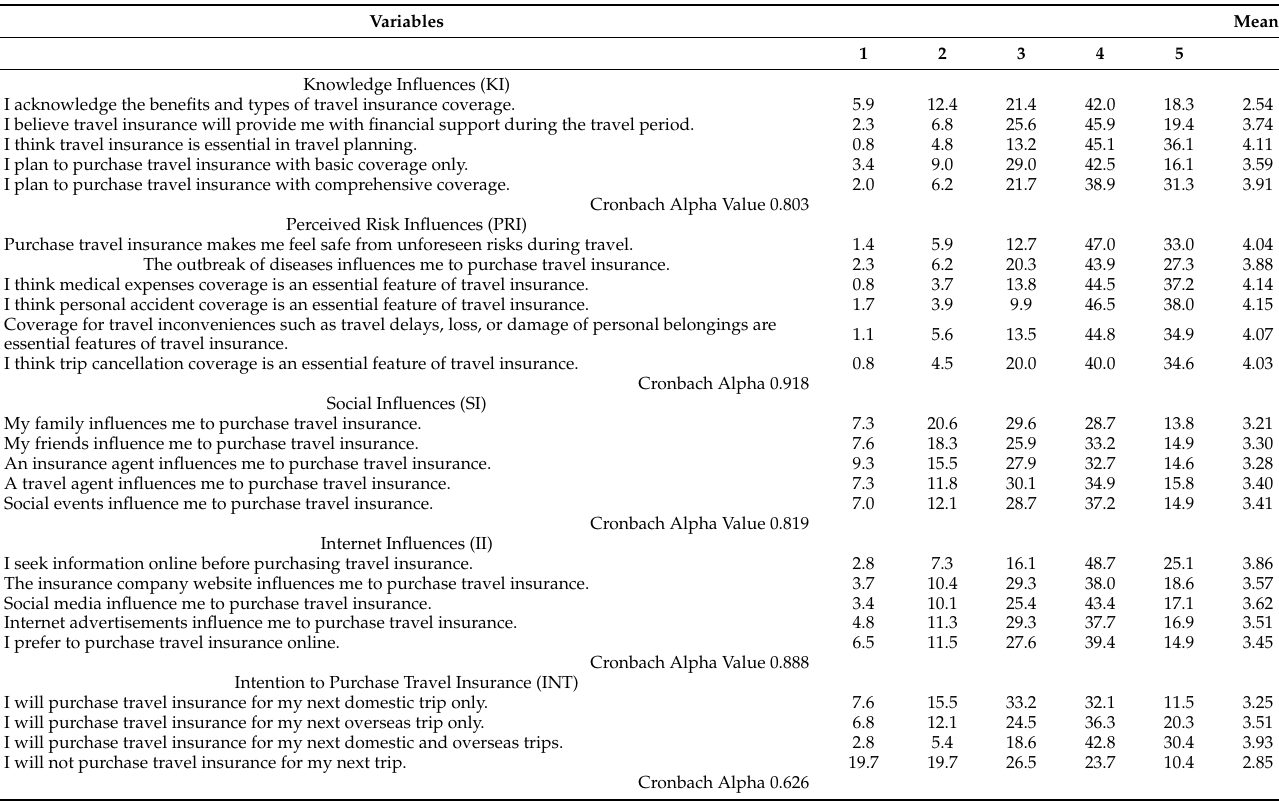
Table 1. Variables descriptive analysis (N = 355). The items were measured using five-point Likert scale:1—strongly disagree, 5—strongly